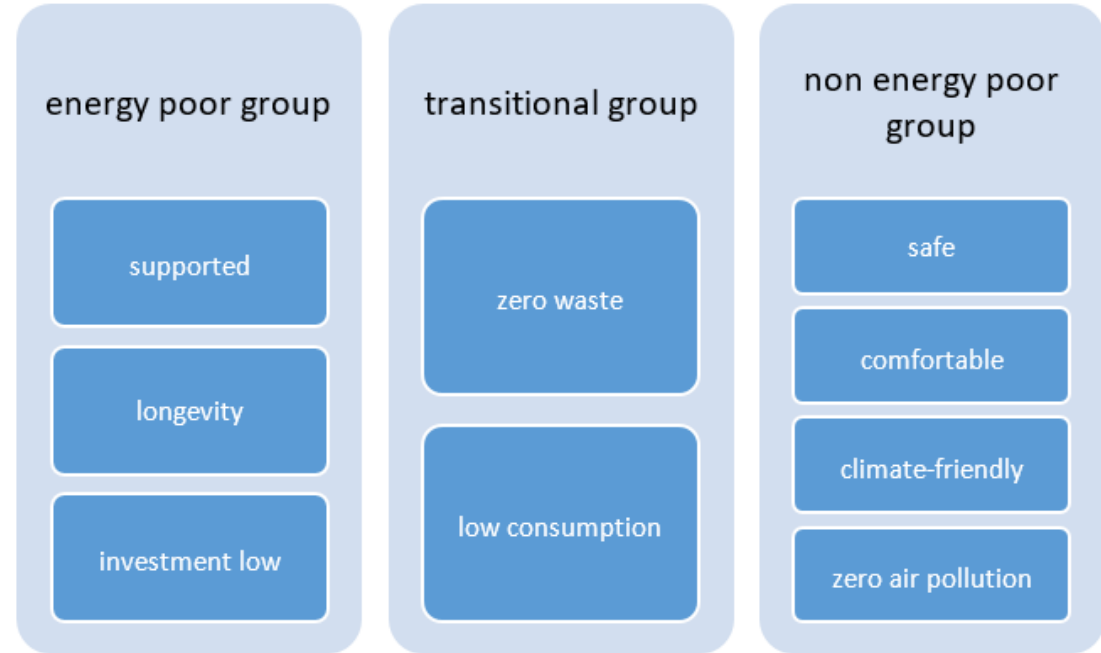
Figure 6. Aspects of great importance in connection with heating methods, according to the groups. Compiled by the authors.